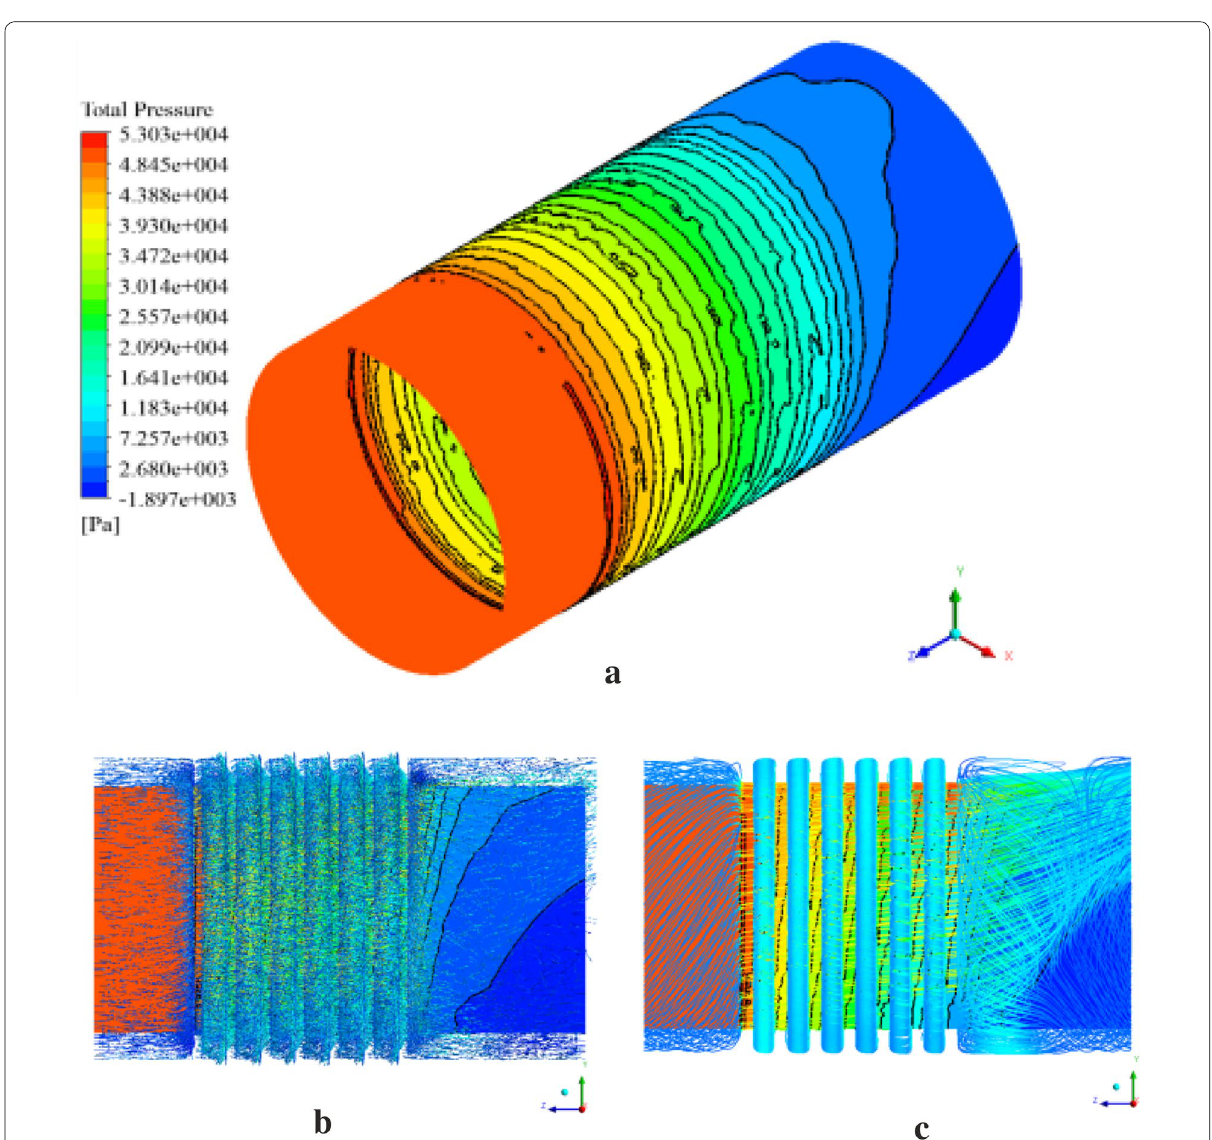
Figure 4 Flow field at axial pre-swirl (100 m/s): a total pressure contours on the rotor surface; b velocity vectors; c velocity